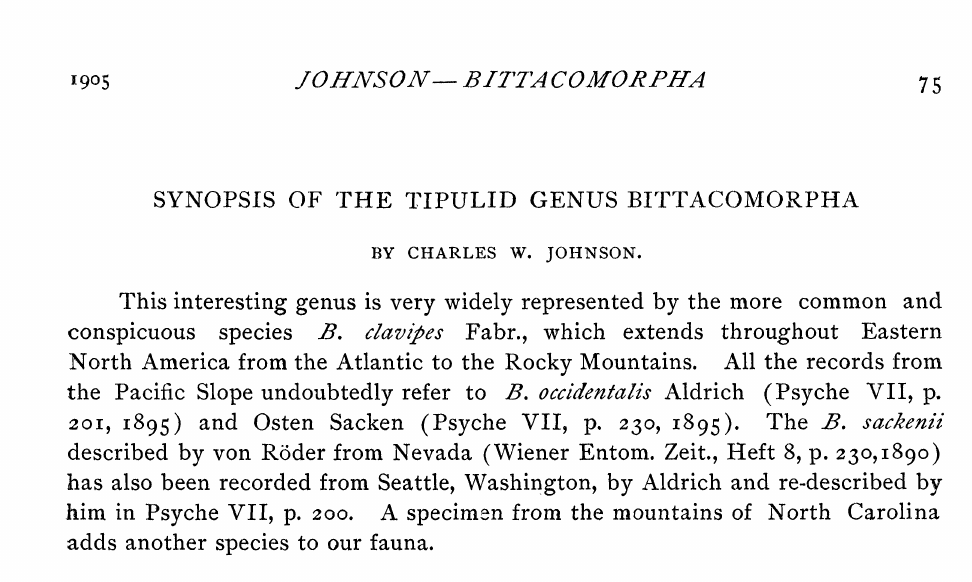
Tibiae annulated with snow white near the